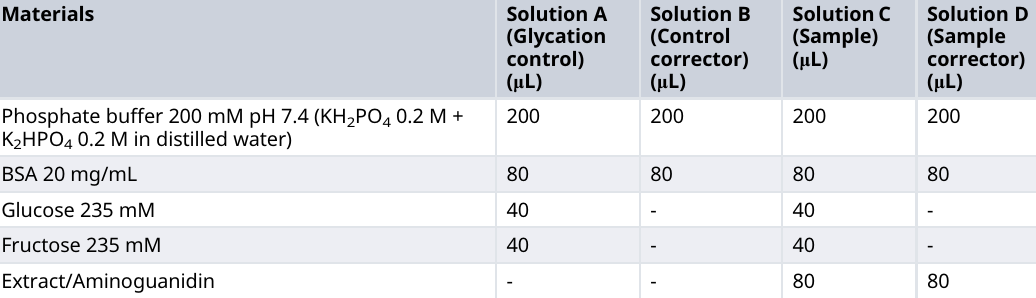
Table 2. The composition of the solution in the anti-glycation activity test.